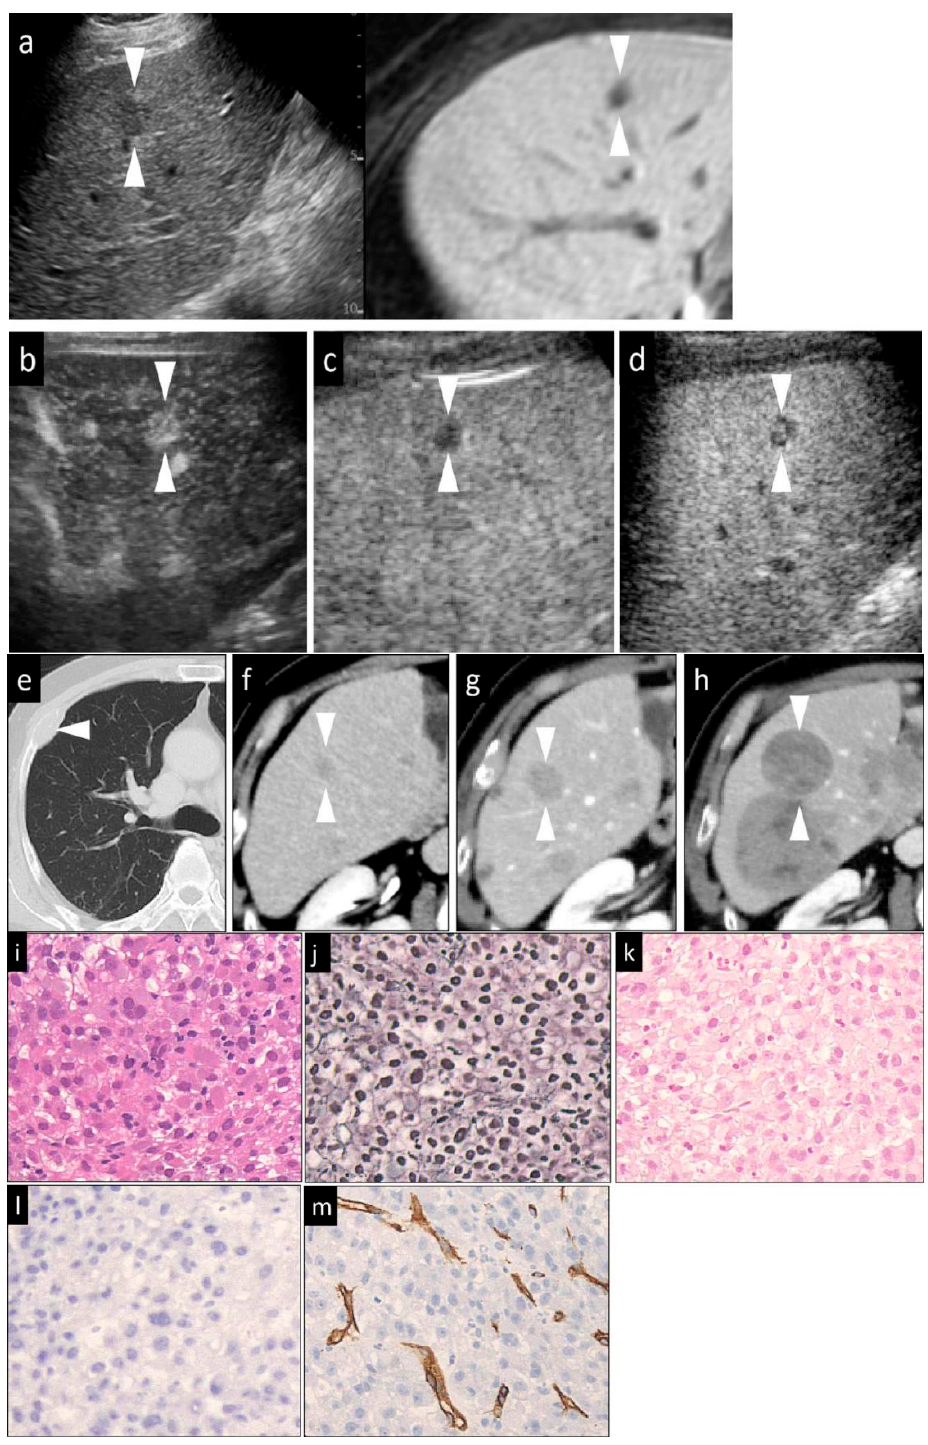
Figure 4. A hypervascular HCC lesion (maximum diameter, 16 mm) in segment V in an 82-year-old male patient with chronic C hepatitis. ( a ) Fusion images combining conventional US (left side) and hepatobiliary-phase image of Gd-EOB-DTPA MRI as reference (right side) on a single screen. The hepatobiliary-phase image of Gd-EOB-DTPA MRI showed a significantly hypointense area in segment V (arrowhead). The target lesion appeared as a well-defined, mild hypoechoic lesion, without a halo, on the conventional US image. ( b ) Arterial-phase Sonazoid CEUS image obtained using low-MI harmonic imaging showed hypervascularity of the lesion with a central non-enhancing area. ( c )